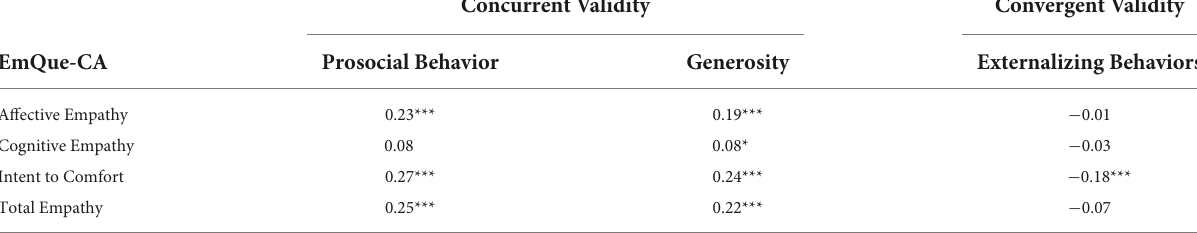
TABLE 5 Pearson correlation coefficients of EmQue-CA dimensions, and measures to evaluate concurrent and convergent